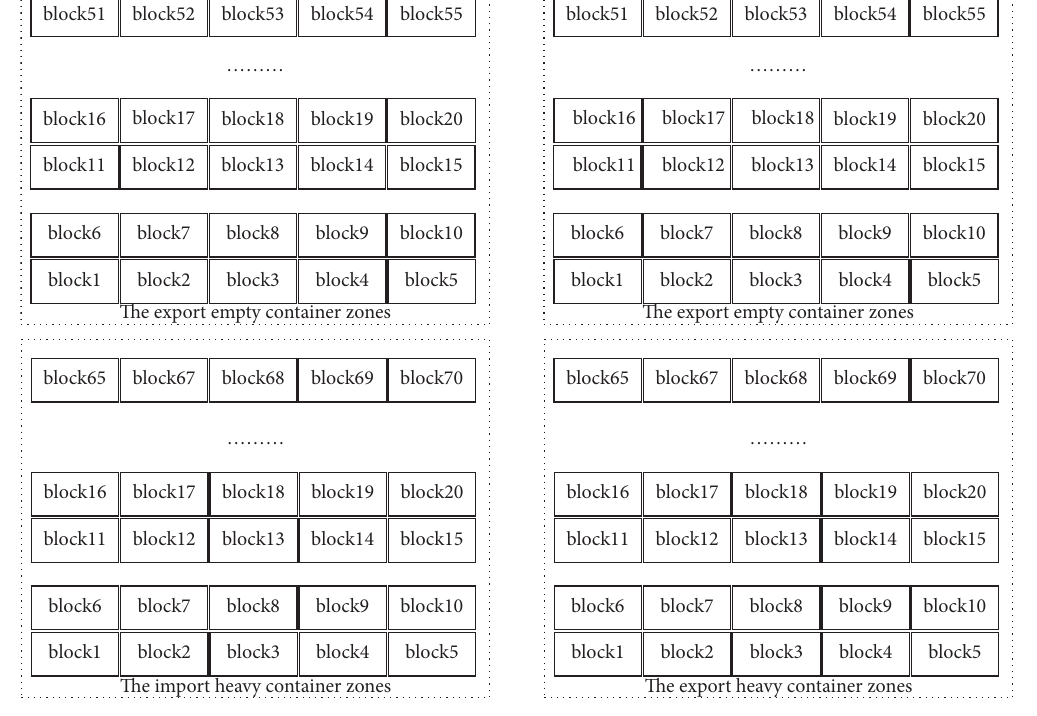
Figure 4: The plane layout of quayside berth and storage yard for testing